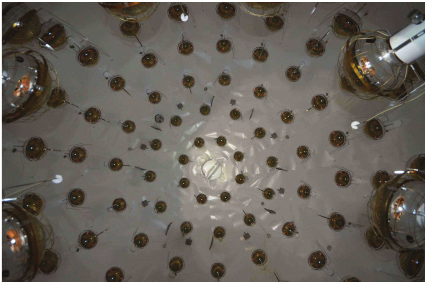
Figure 3: Internal view of the CTF muon